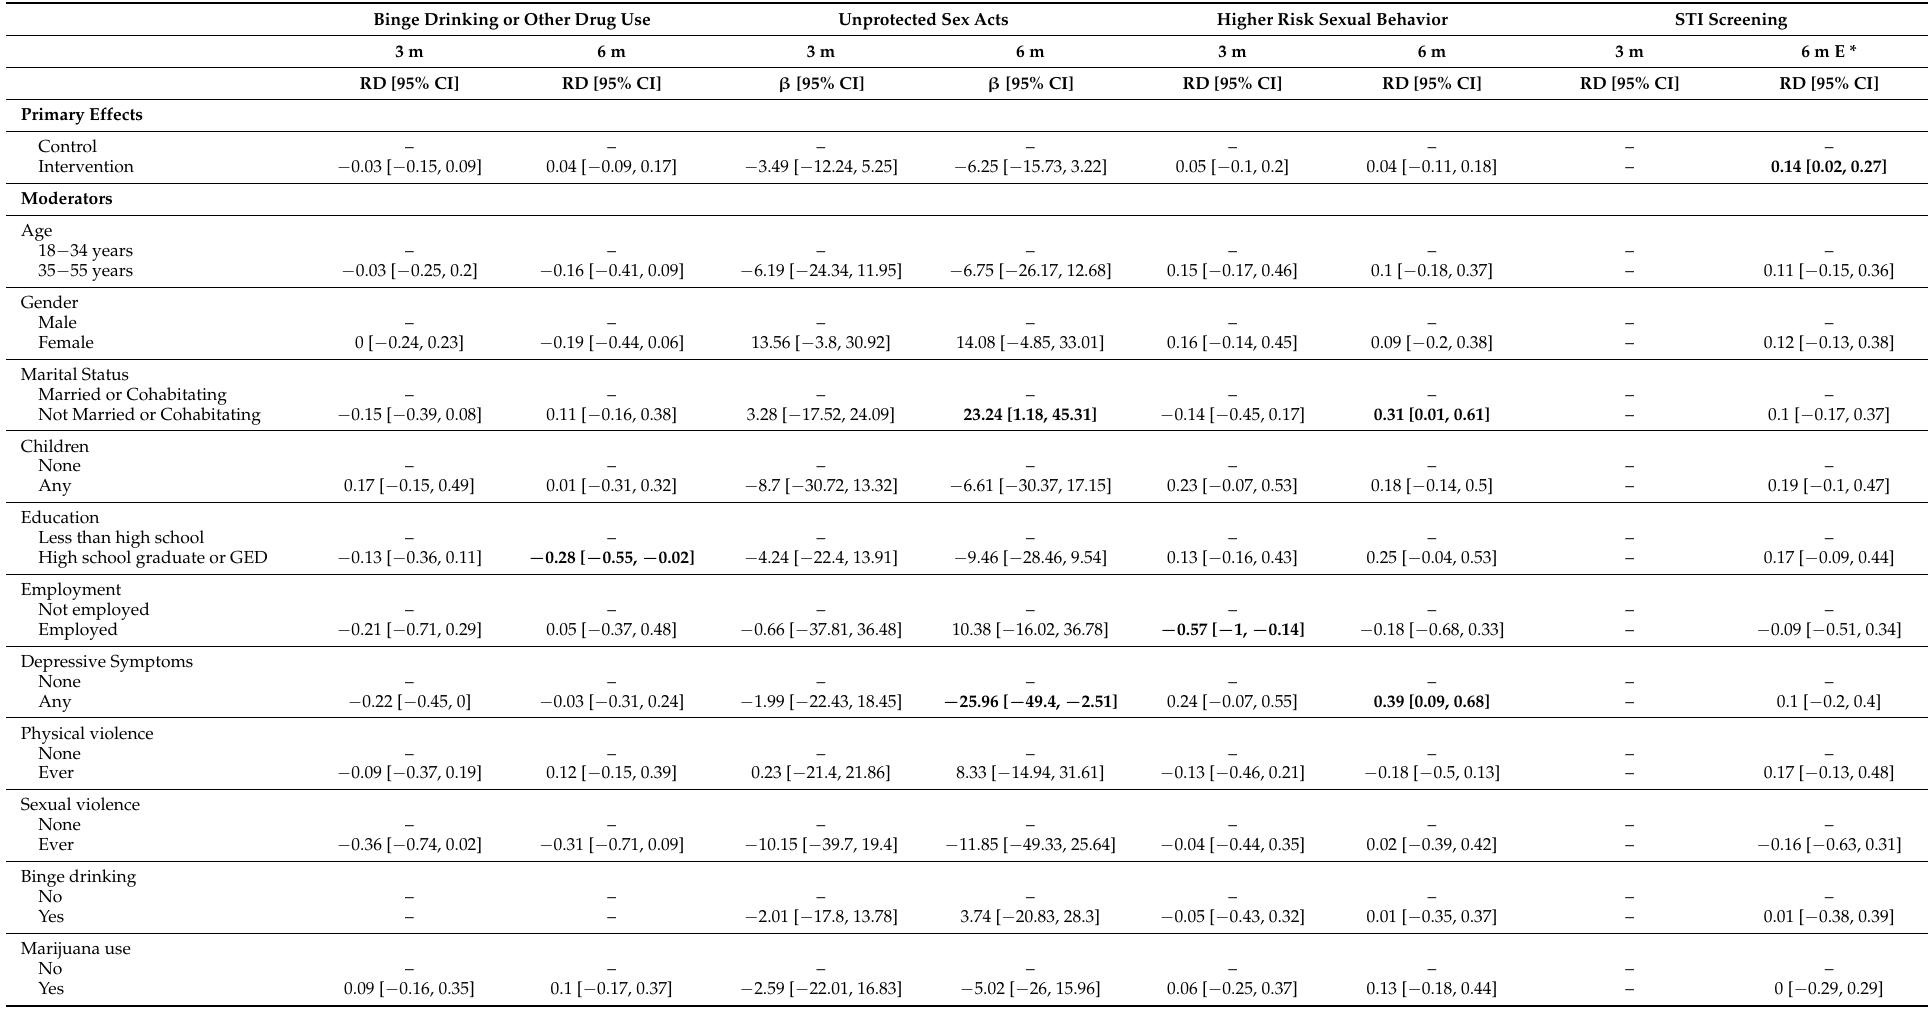
Table 2. Primary and moderation model estimates of intervention effects among participants in a trial of an intervention to reduce sexually transmitted infection risks among Native Americans with binge substance use ( n = 301). Binge Drinking or Other Drug